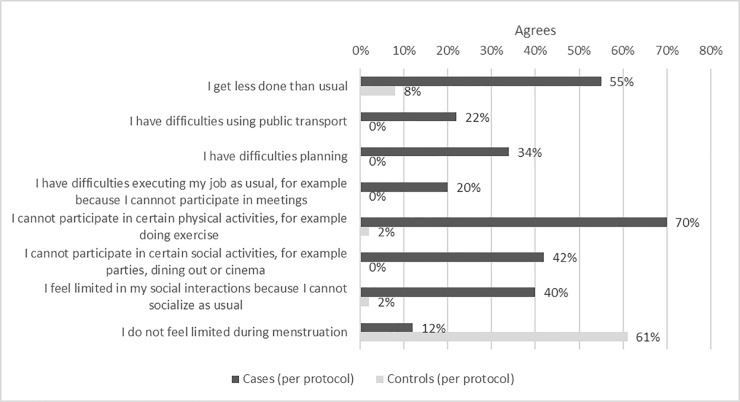
In what way do you feel limited during menstruation?Subjects were requested to agree or disagree with the above statements, the difference between the case and control group is significant for all individual items, p-values ≤ 0.001. P-values calculated by Fisher exact tests.